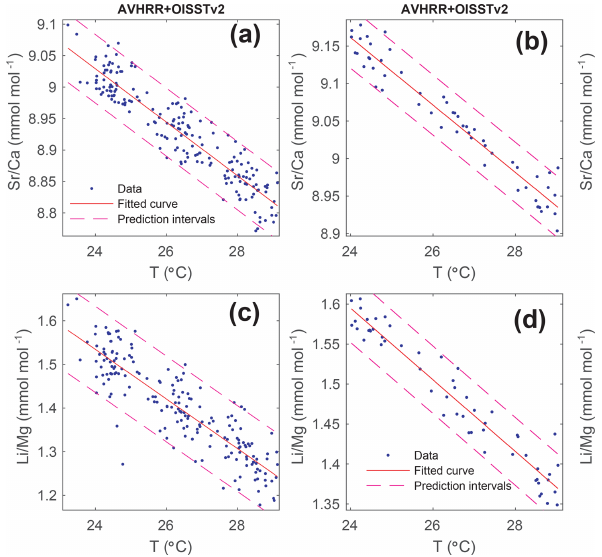
Figure 5. Linear regressions of trace element ratios with AVHRR- OISSTv2 (Banzon et al., 2016) for core EU3 1981–2012 (a, c) and EU2 2003–2012 (b, d) . The trace element records were calibrated using the respective weighted least squares regression equations of the bimonthly correlations obtained for each of the core records from the two sites. The 95% confidence intervals of the regressions are indicated. Regression equations are provided in Table 2.